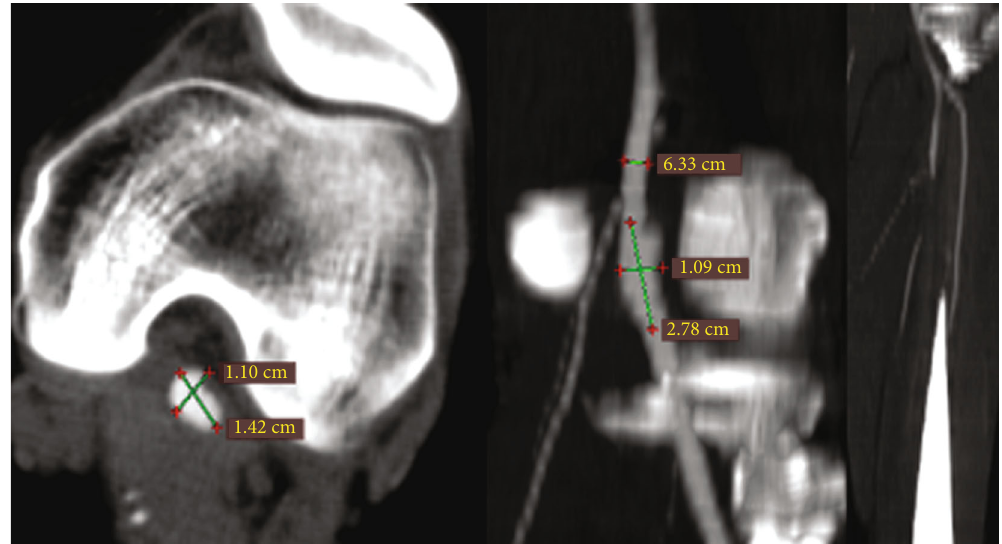
Figure 1: Computer tomography angiography demonstrating fusiform aneurysm of the left popliteal artery with a maximal diameter of 14 mm and distal occlusion of tibial and peroneal